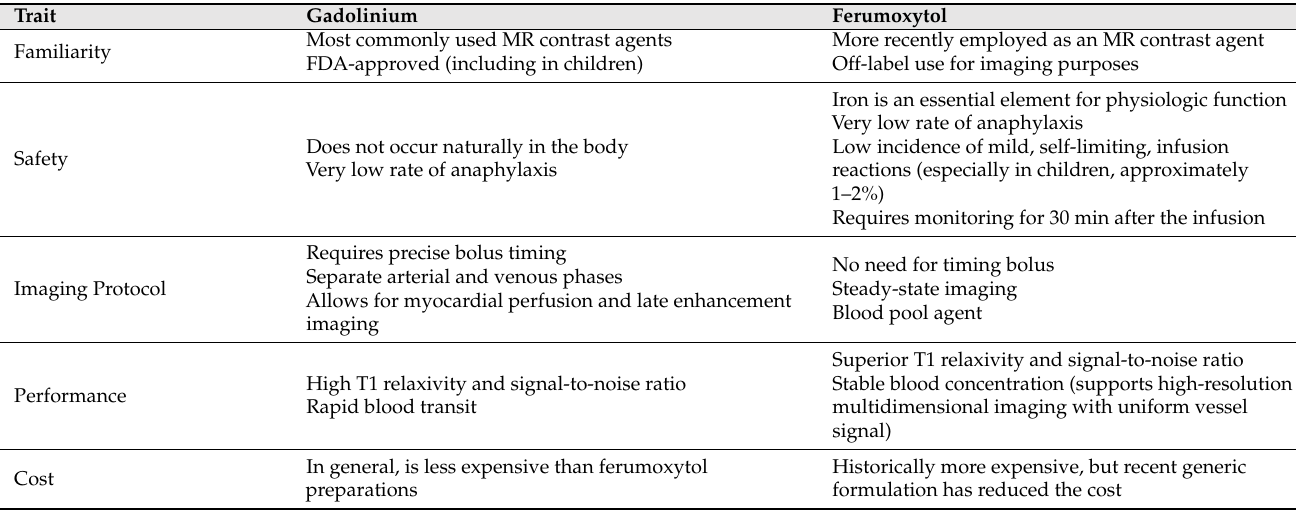
Table 2. Comparison of Gadolinium-Based Contrast Agents to